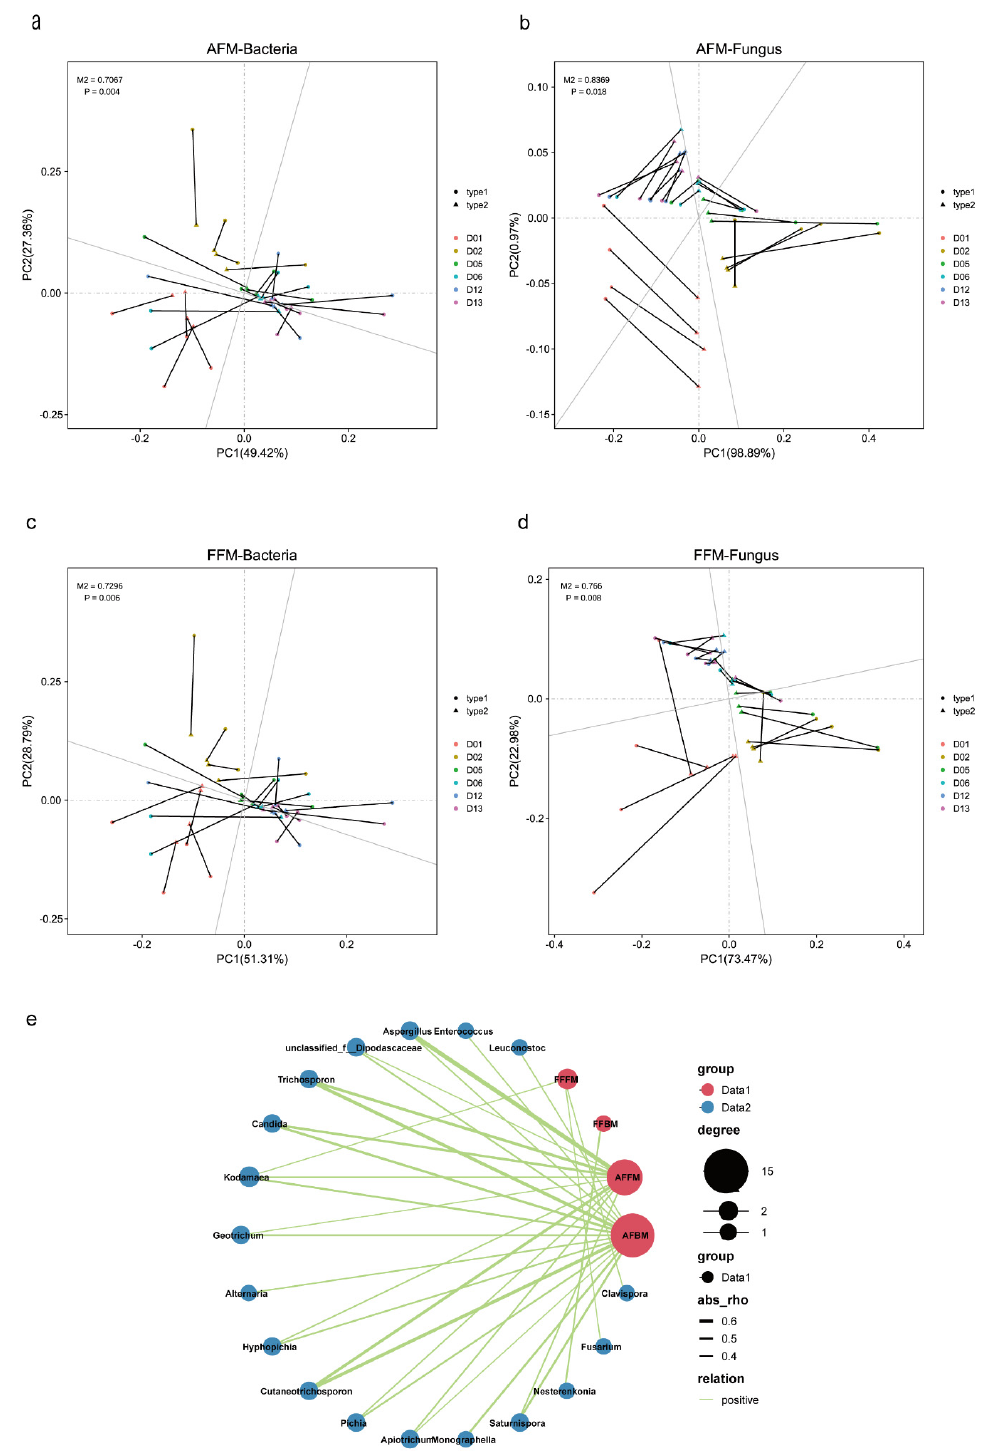
Figure 4. Effects of microbial interactions on functional microbial communities. Influence of bacterial and fungal communities on AFM ( a , b ) and FFM ( c , d ) by Procrustes analysis. Type1 represents bacterial or fungal communities, and Type2 represents the species. The length of the line is the residual value between the two, the shorter the line, the smaller the residual value. Network analysis of the correlation between functional microbial communities and other microbial communities ( e ). Red circles represent function microbial communities and blue circles represent species that are correlated with function microbial